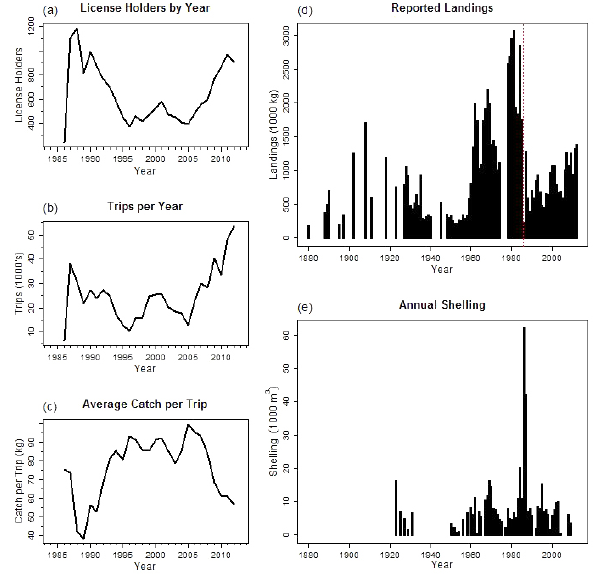
Fig. 3 . Reported Apalachicola Bay, Florida oyster